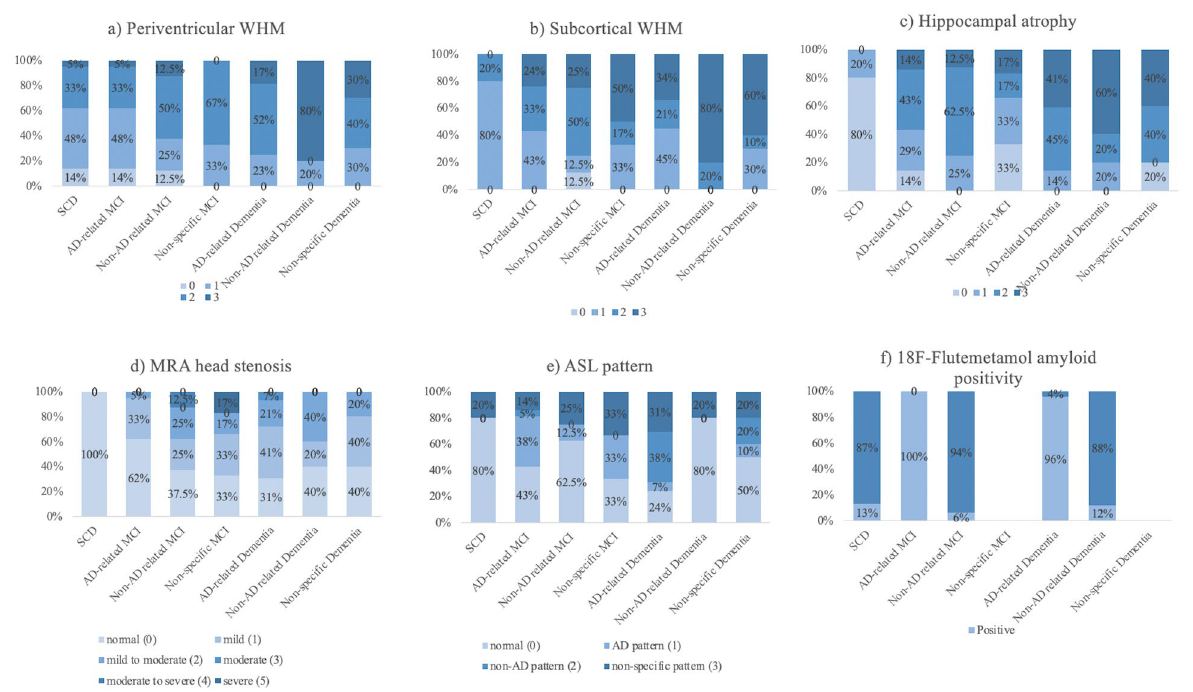
Figure 2. MRI-based findings in each etiological subgroup. ( a ) periventricular WMH; ( b ) subcortical WMH; ( c ) hippocampal atrophy; ( d ) MRA head stenosis; ( e ) ASL pattern and 18F-Flutemetamol-based finding in each etiological subgroup shown as distribution of ( f ) amyloid positivity.